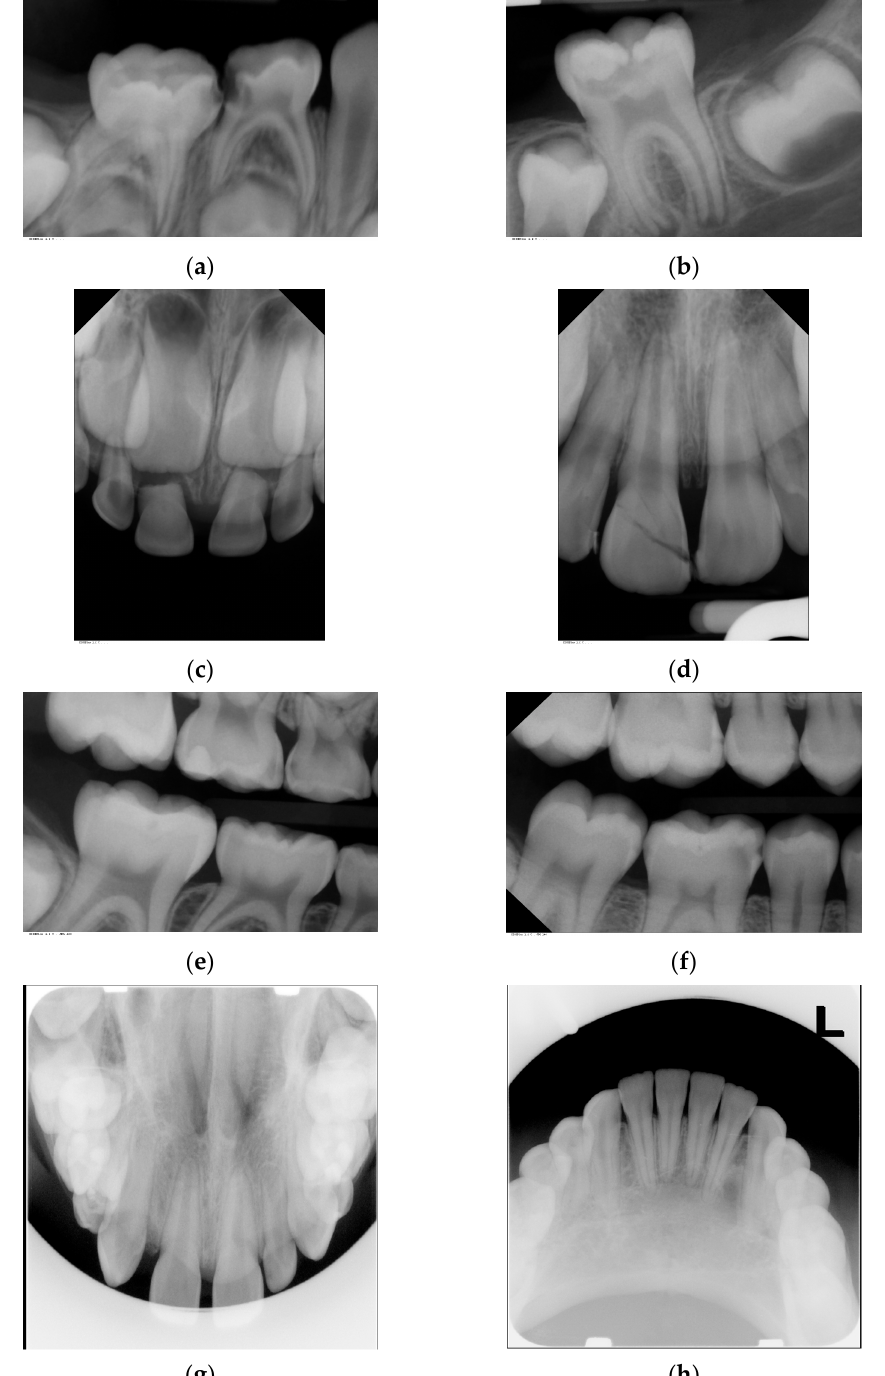
Figure 1. Examples of investigated intraoral radiographs: ( a ) dental radiograph of primary molars for caries and apical diagnostics; ( b ) dental radiograph of permanent molar for caries progression and apical diagnostics; ( c ) dental radiograph of primary teeth for trauma diagnostics; ( d ) dental radiograph of permanent teeth for trauma diagnostics; ( e ) bitewing radiograph for caries detection in primary molars; ( f ) bitewing radiographs for caries diagnostics in permanent molars; ( g ) occlusal radiograph for diagnosis of tooth germ position in the upper jaw; ( h ) occlusal radiograph for diagnosis of pathology in the lower